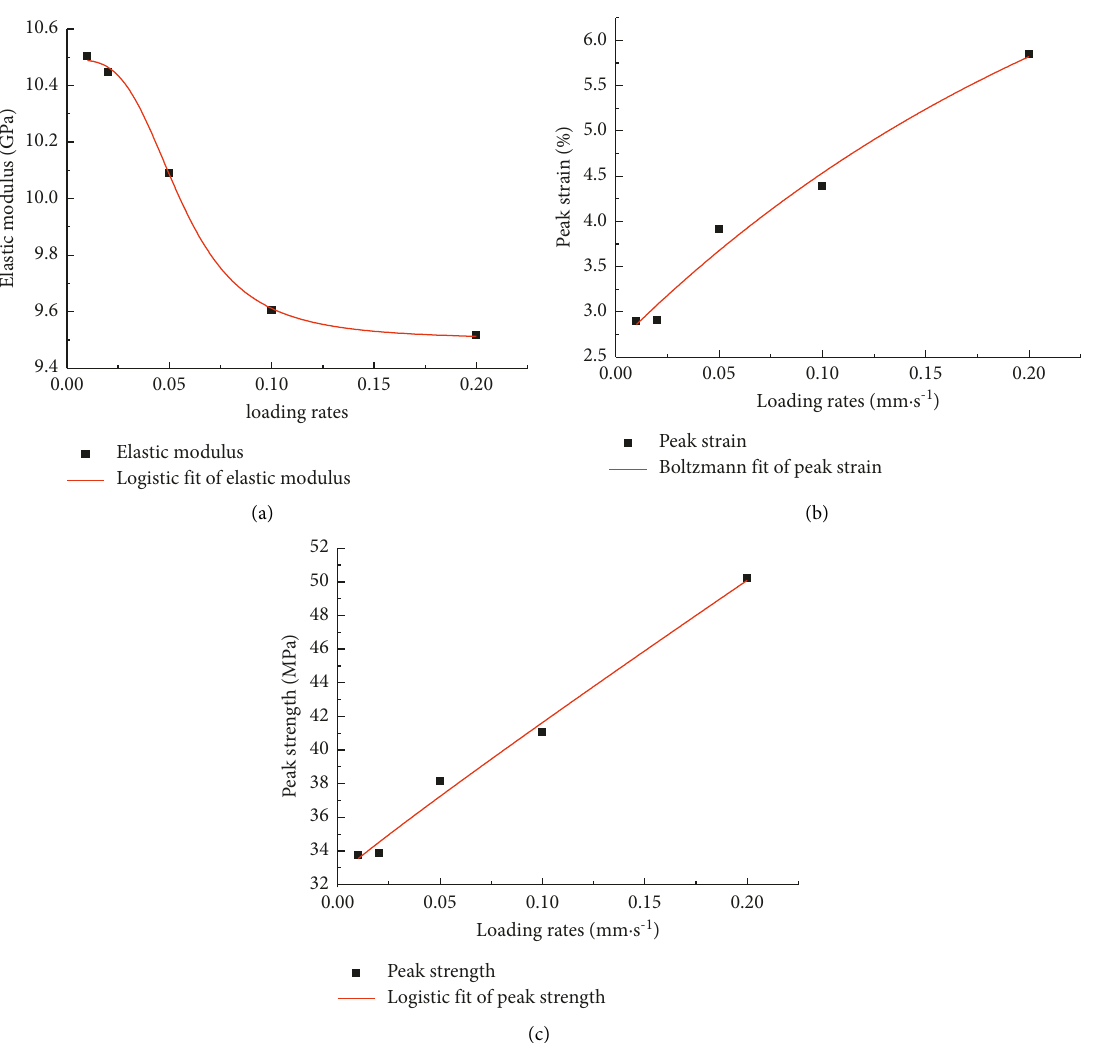
Figure 4: The variation trends of elastic modulus, peak strength, and peak strain of coal-rock combined samples under different loading rates. (a) Elastic modulus. (b) Peak strain. (c) Peak